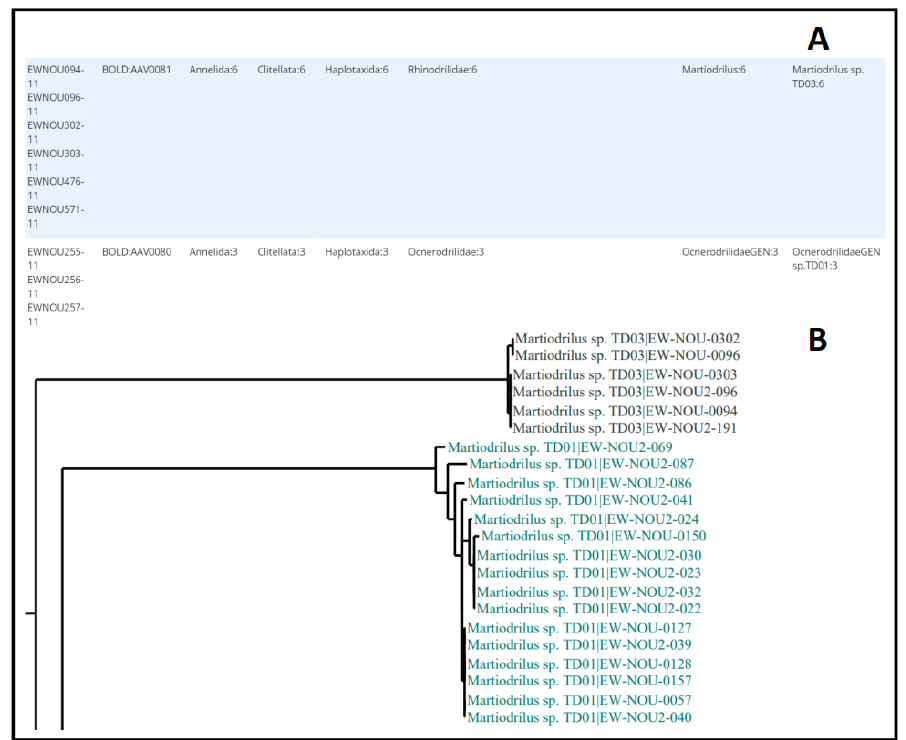
Figure 3. Output results obtained with the RESL method: ( A ) extract from the file of sequences from dataset 1 distributed in the different OTUs; ( B ) extract from the neighbor joining tree obtained with the same sequences from the BOLD platform, showing the distances between sequences and the way they are organized in OTUs.